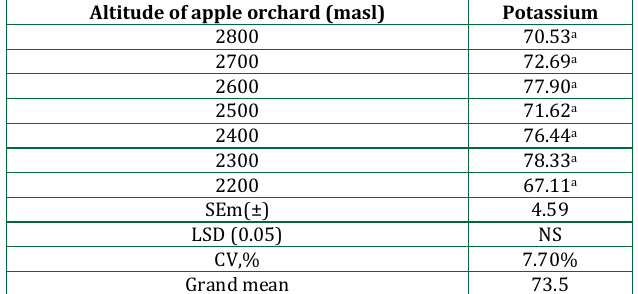
Table 9: Potassium variation in different altitude apple orchards in Apple Zone, Kalikot Altitude of apple orchard (masl)